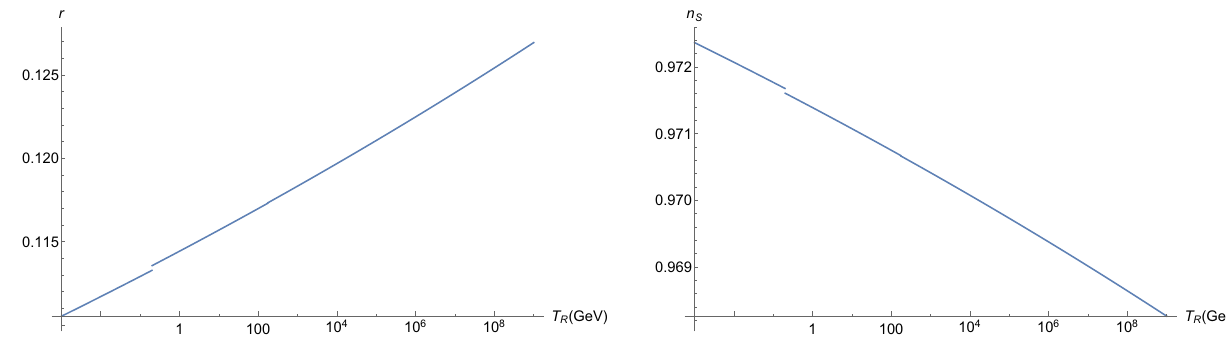
Fig. 9 Evolution of the tensor/scalar ratio r (left) and the spectral index n s (right) versus the reheating temperature T R